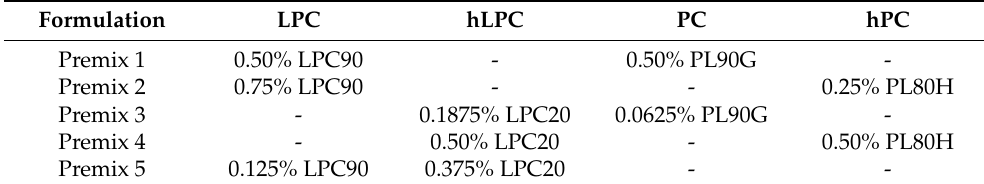
Table 2. Composition of the investigated premix